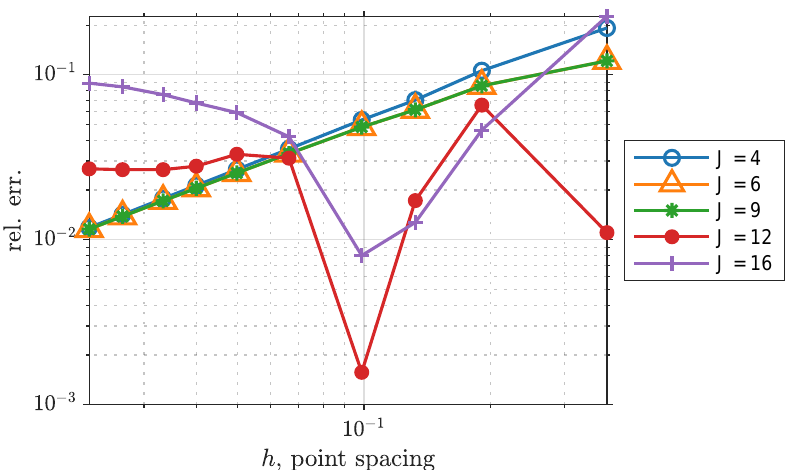
Figure 1. Relative error versus point spacing associated with the calculation of the total surface area of the sphere via the expression for the metric given in Equation (34), for five choices of local sample size J =